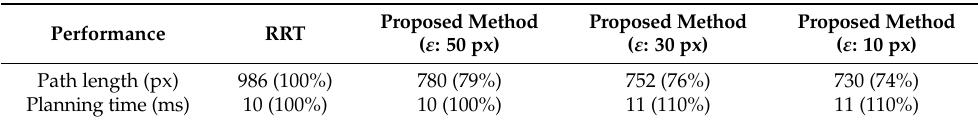
Table 3. Experimental results of Map 2 (numbers in parentheses (averages of repeating trial 100 times) are relative ratios to RRT results (values less than 1 are counted as 1)).